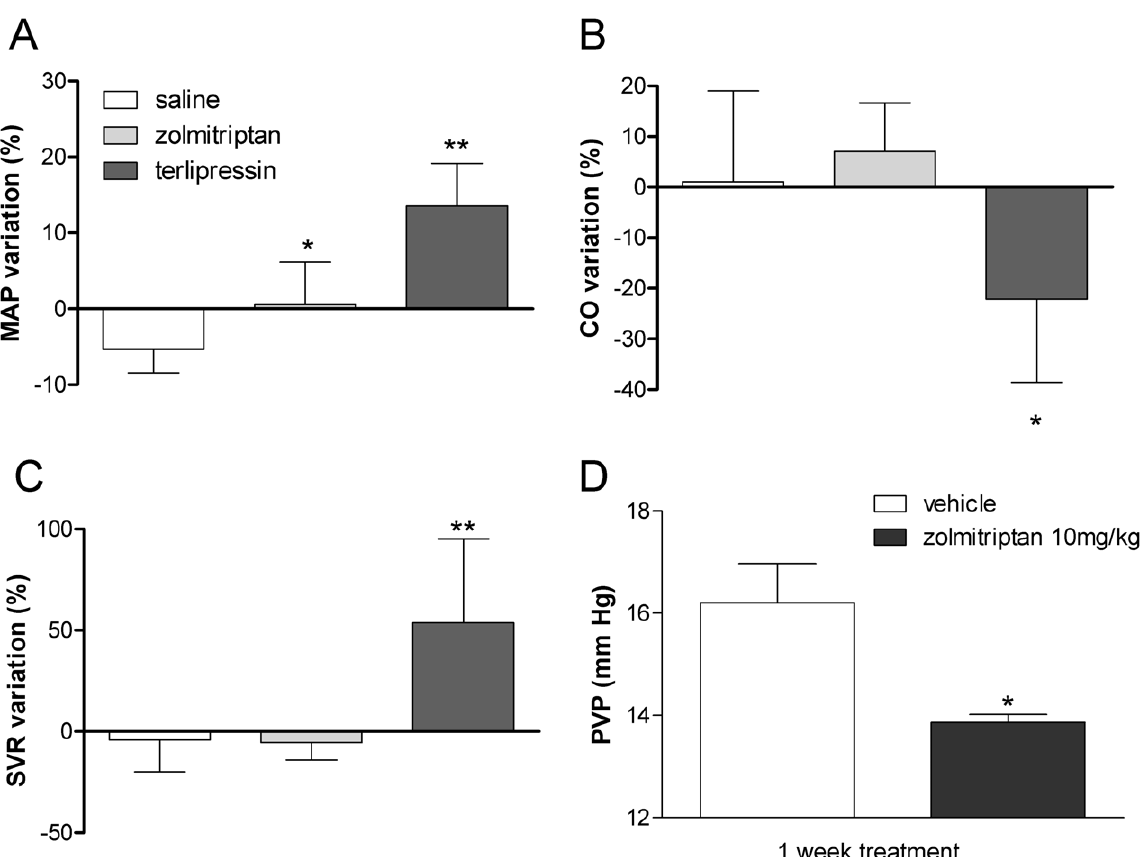
Figure 2. Systemic and chronic effects of zolmitriptan and terlipressin in CBDL-rats. Measurement of arterial pressure (MAP) (A), cardiac output (CO) (B) and systemic vascular resistance (SVR) (C) after zolmitriptan, terlipressin or saline administration. (D) Effect of chronic administration of zolmitriptan in portal pressure (PVP). */**p , 0.05/0.01 vs saline.